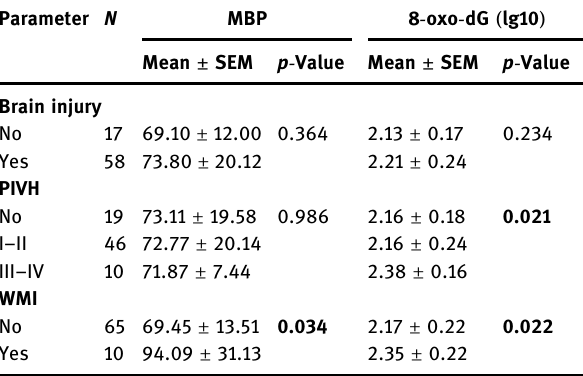
Table 2: Plasma MBP and 8 - oxo - dG levels Parameter N